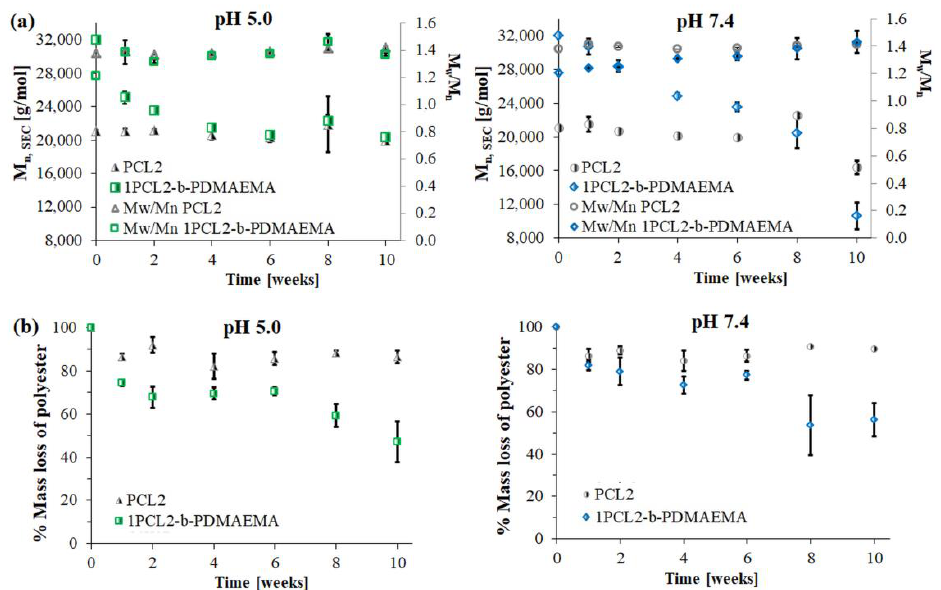
Figure 3. Dependence of M n , changes over time for 1PCL2- b -PDMAEMA and PCL2 based on SEC ( a ) and percentage weight loss of PCL block based on 1 H NMR ( b ) analyses.